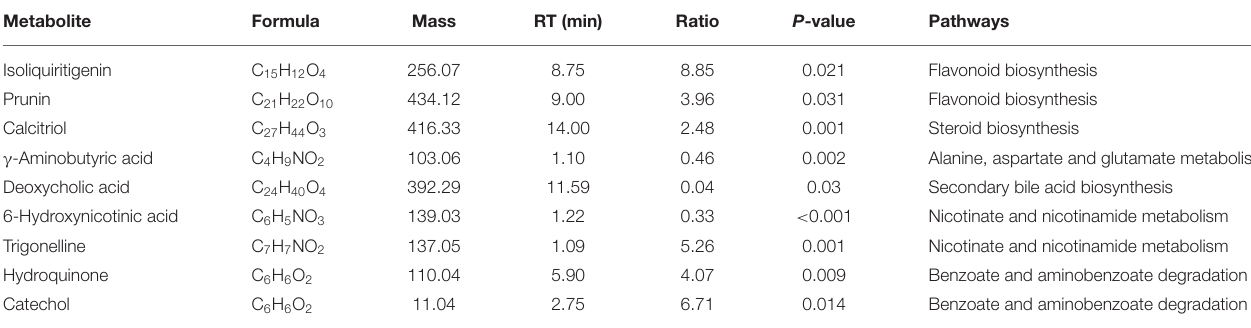
TABLE 2 | Summary of the candidate biomarkers between control and CCl 4 groups. Metabolite